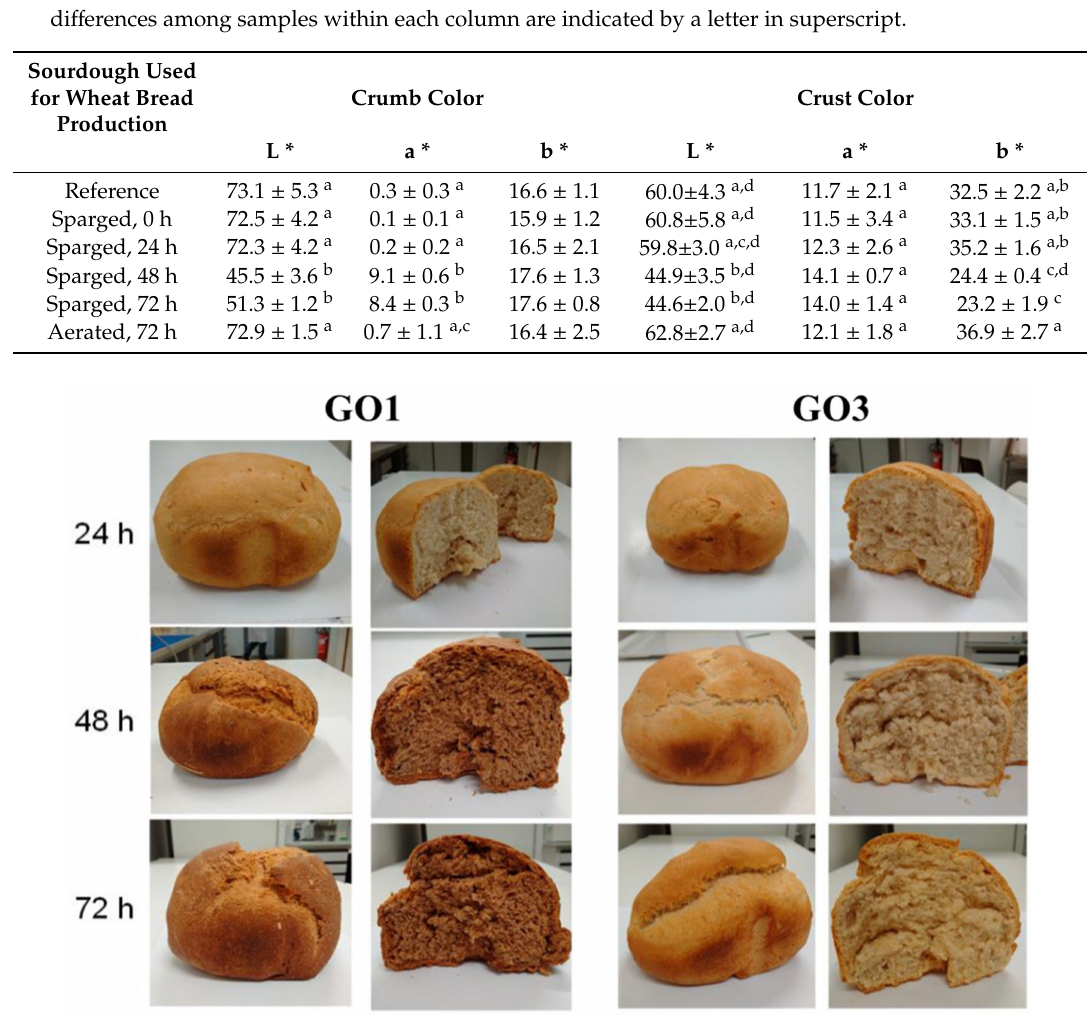
Figure 9. Wheat breads made with sourdoughs obtained through Gluconobacter oxydans IMDO A845 (GO1)-initiated fermentations (aeration through the wheat flour–water mixture) and G. oxydans IMDO A845 (GO3)-initiated fermentations (aeration through the fermenter headspace) at three di ff erent sampling